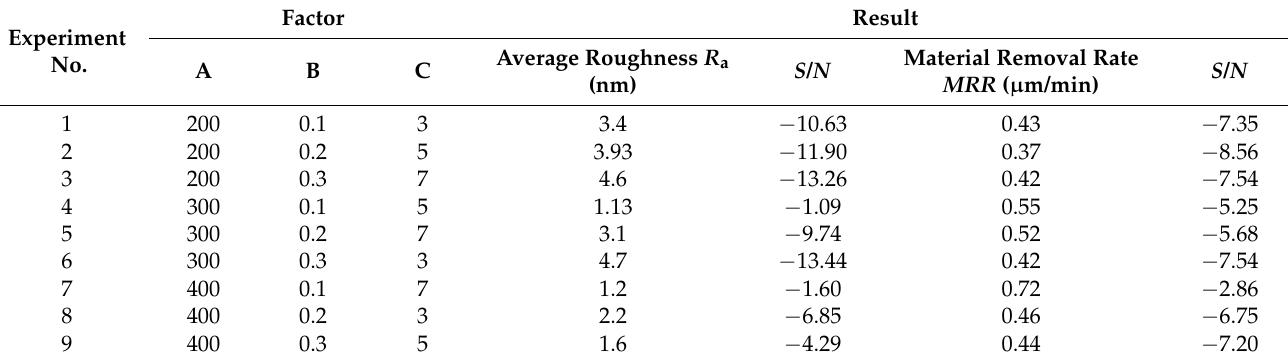
Table 2. Orthogonal experimental parameters and experimental